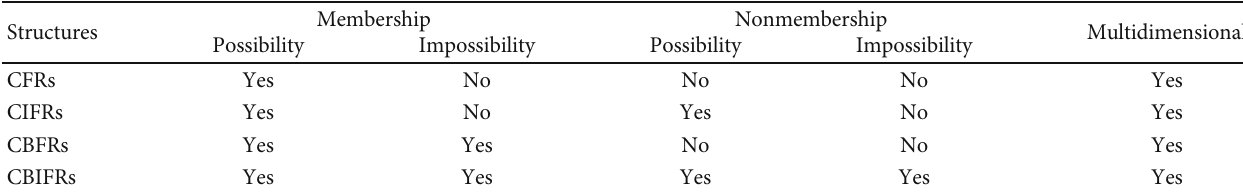
Table 2: Comparative